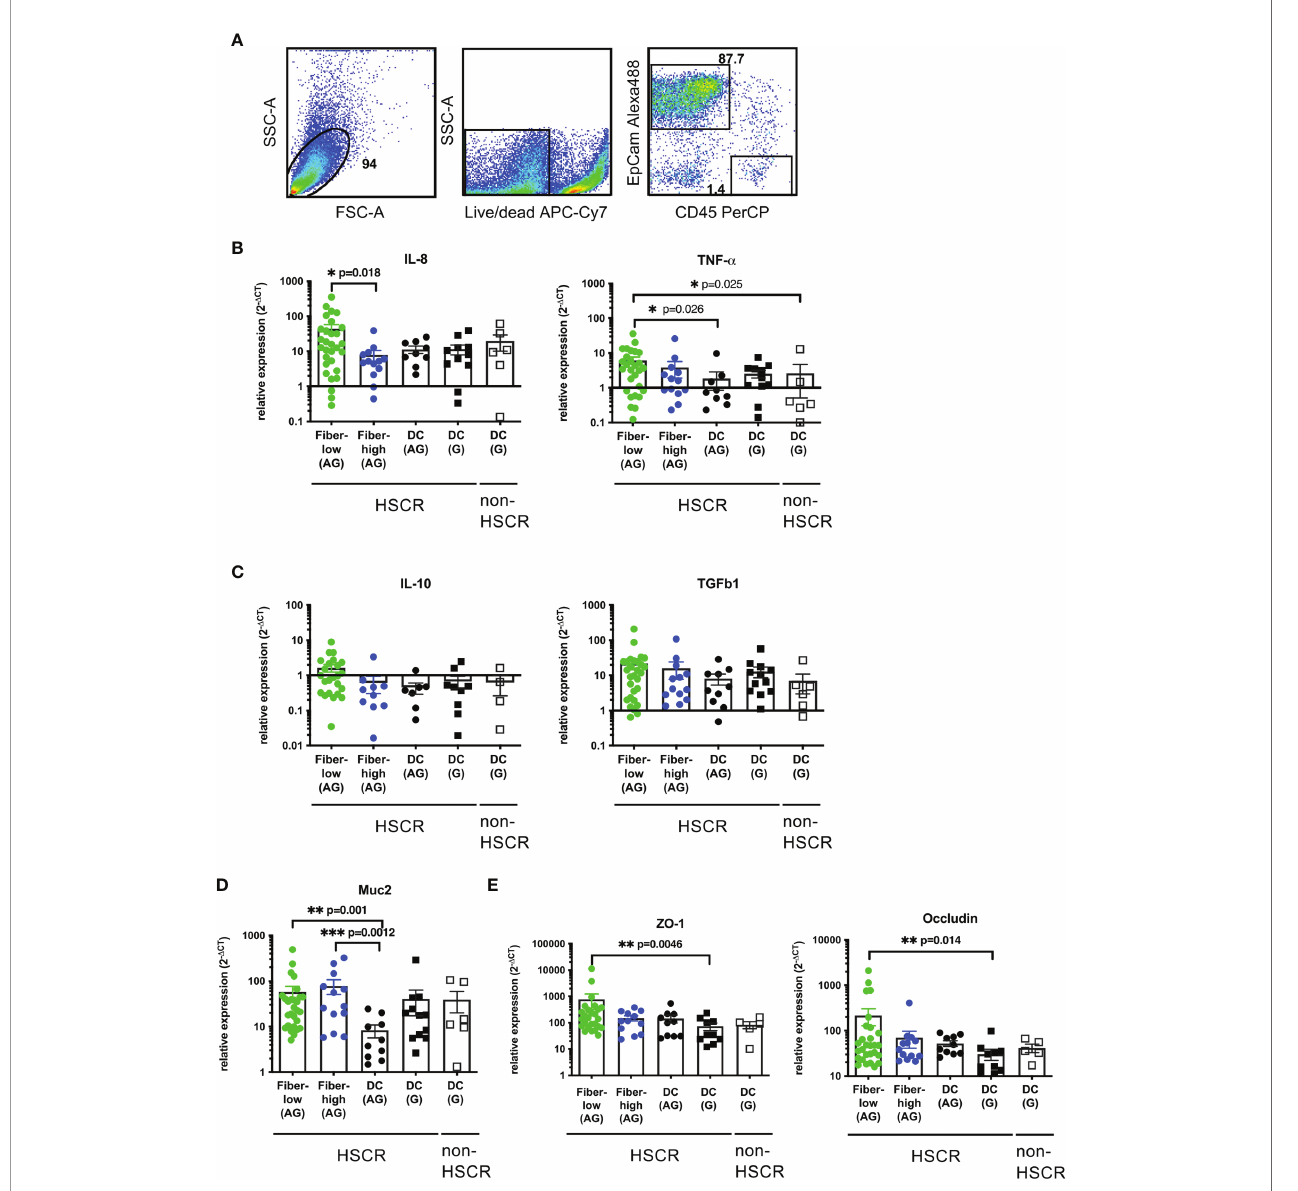
FIGURE 2 | Expression of cytokines, mucin, and tight junctions in patient-derived IEC. FACS analysis of isolated IEC. Cells were isolated by digestion and puri fi ed using a 20%/40% Percoll gradient. Purity was determined by fl ow cytometric analysis using antibodies against human CD45-PerCP and EpCam-Alexa488. Unstained controls were used to determine the negative population (A) . Puri fi ed epithelial cells were immediately lysed, total RNA isolated and cDNA synthesized. Relative gene expression was calculated using the 2- D CT method, with b 2-microglobulin as the housekeeping gene (B – E) . Scatter plots with bar show mean ± SEM. Signi fi cance was determined using the Kruskal-Wallis test (*p ≤ 0.05, **p ≤ 0.01, ***p ≤ 0.001). Fiber-low (n=30); Fiber-high (n=13); DC AG (n=10); DC G, HSCR (n=12); DC G, non-HSCR (n=6). Not detectable samples: Fiber-low: TNF- a (n=2); IL-10 (n=6); TGF- b (n=1); Muc2 (n=2); ZO-1 (n=4); occludin (n=2). Fiber- high: IL-10 (n=4); ZO-1 (n=1). DC AG: IL-8 (n=1); TNF- a (n=1); IL-10 (n=3). DC G, HSCR: IL-8 (n=1); TNF- a (n=1); IL-10 (n=3); ZO-1 (n=2); occludin (n=2). DC G, non-HSCR: IL-10 (n=2); ZO-1 (n=1); occludin (n=1). DC, descending colon; AG, aganglionic; G,